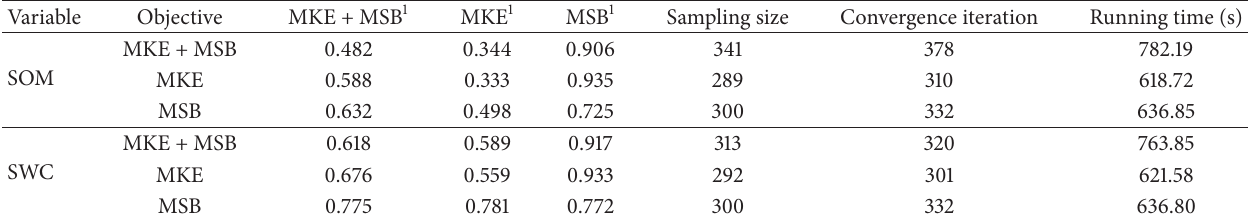
Table 2: Summary results of the modified particle swarm optimization algorithm.